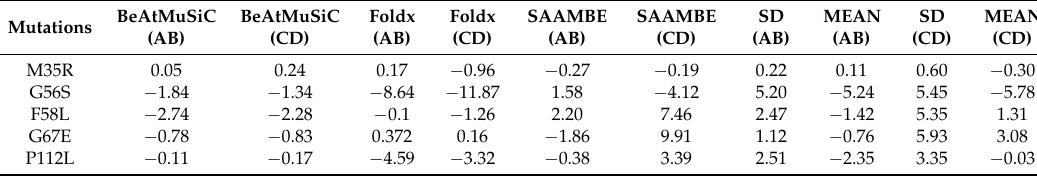
Table 3. Predictions of dimer affinity change due to missense mutations. The calculated binding free energy changes are in kcal/mol. ∆∆ G > 0 indicates stabilization while ∆∆ G < 0 indicates destabilization. The calculation is performed for “AB” dimer and “CD” dimer for comparison. The mean value is the average of all calculated results for each mutation. SD is also calculated to quantify variation of values.